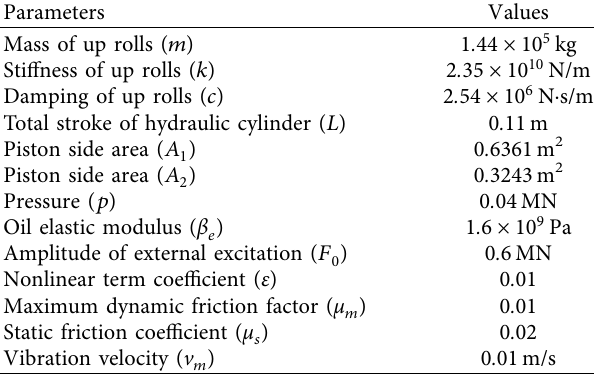
Table 1: Vibration parameters of rolling mill